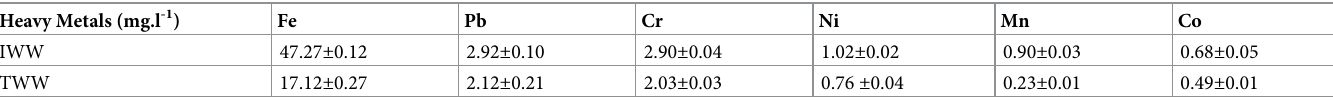
Table 3. Concentrations of heavy metals in soil irrigated with IWW and TWW. Heavy Metals (mg.l -1 )